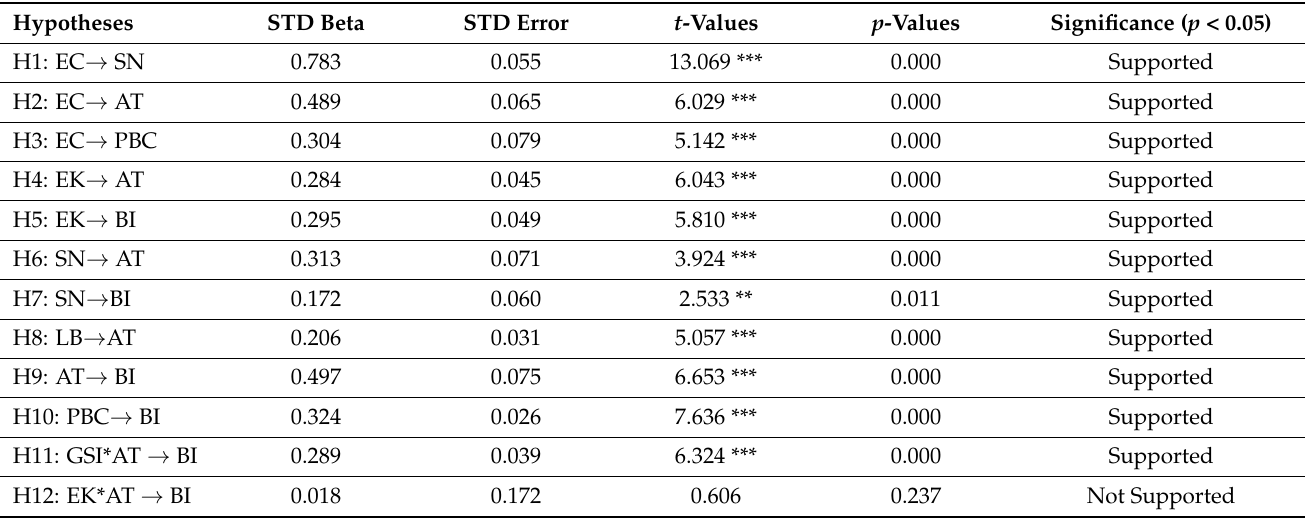
Table 8. Structural Model and the Hypothesis Testing Result.